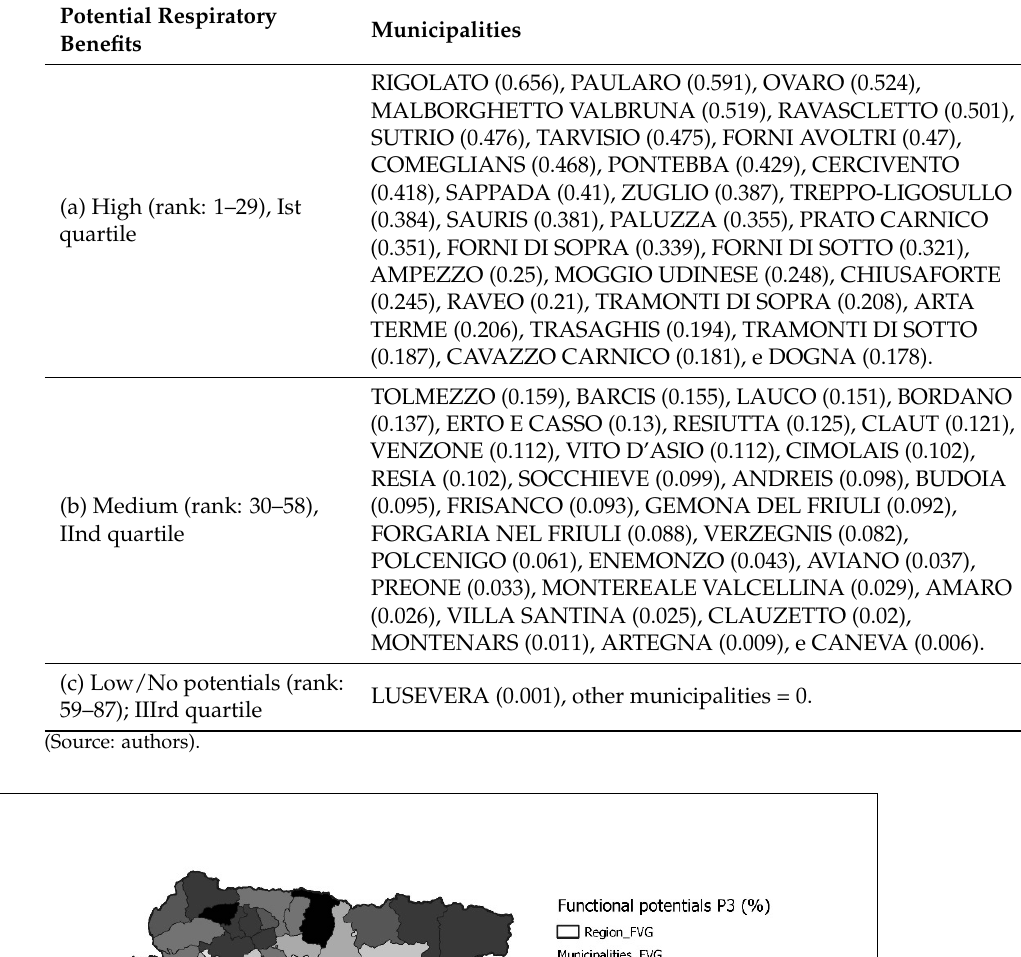
Table 5. Potential respiratory benefits of forest heritage by municipality through applying model P2.